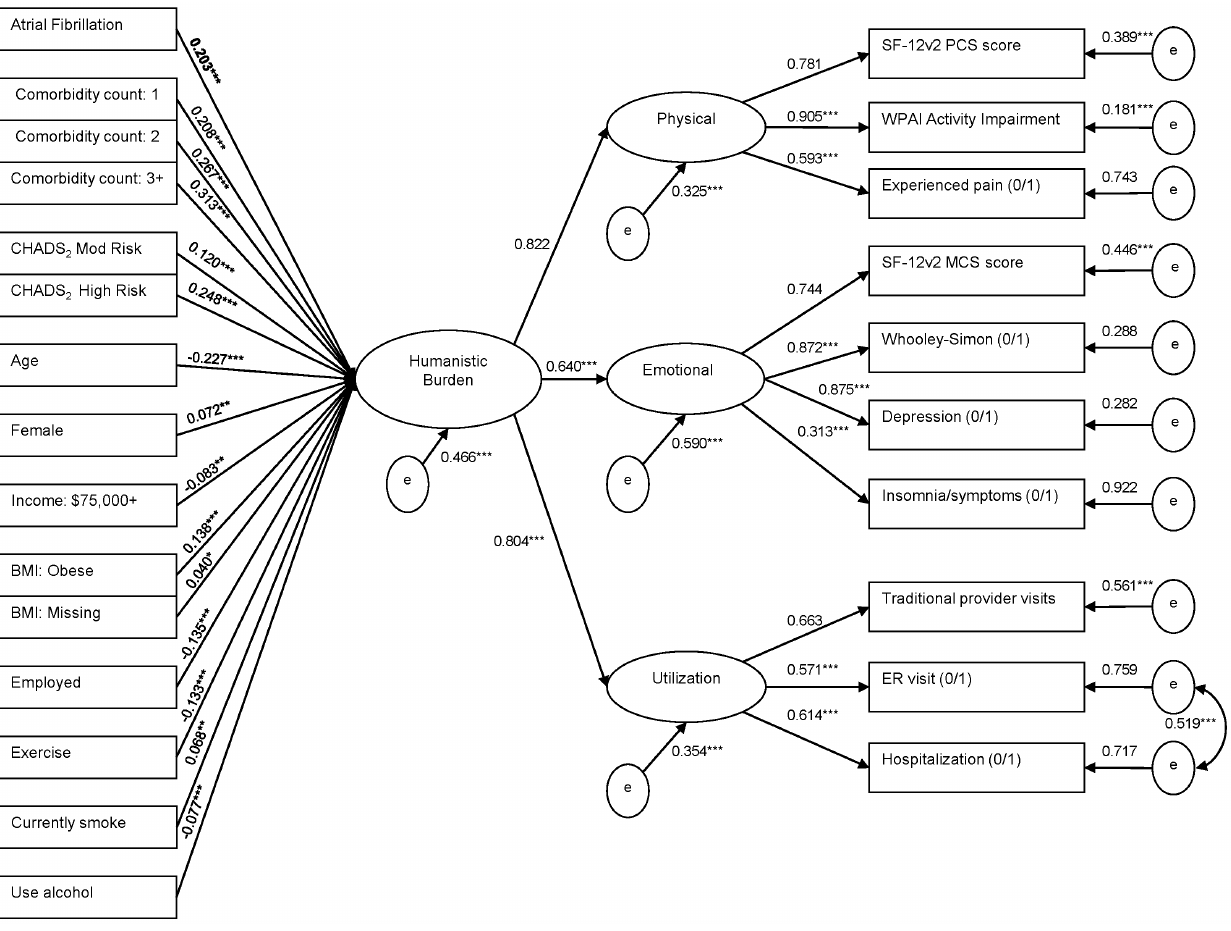
Figure 2. Overall Humanistic Burden as a function of AF, demographics, comorbidities, and behavioral factors. Note. Nonsignificant predictors of burden are not presented above: non-white; single; divorced/widowed/separated; college education or higher; household income: $ 25,000 to $ 49,999, $ 50,000 to $ 74,999, and decline to answer; uninsured; BMI: overweight. Reference groups include: non-AF matched controls, male, white, married/living with partner, less than college education, household income: , $ 25,000, insured, BMI: underweight/normal, unemployed, not exercising, not currently smoking, not using alcohol, comorbidity count of 0, and CHADS2 low risk. Standardized estimates and residual variances are shown. Topmost indicators per factor set the scale. Dichotomous indicators include ‘‘(0/1).’’ *p , 0.05. **p , 0.01. ***p , 0.001. No p-values are available for the scale setters and categorical residuals.